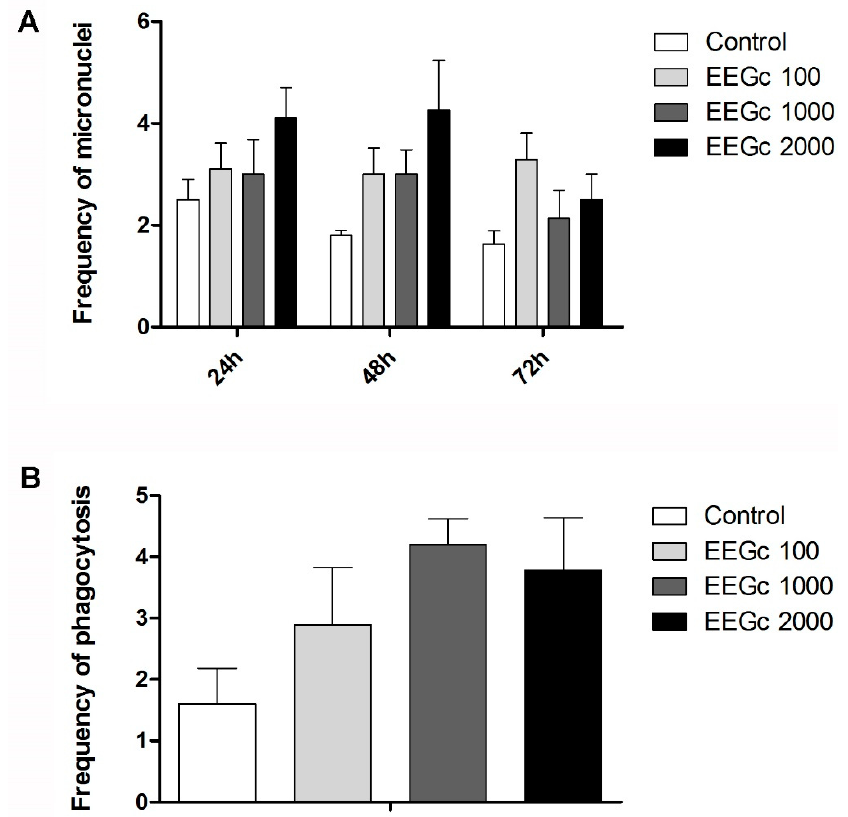
Figure 1. ( A ) Frequency of micronuclei in females treated with the ethanolic extract G. celosioides (EEGc). ( B ) Frequency of splenic phagocytosis in females treated with the ethanolic extract G. celosioides (EEGc). Statistical test: ANOVA/Tukey ( p > 0.05).